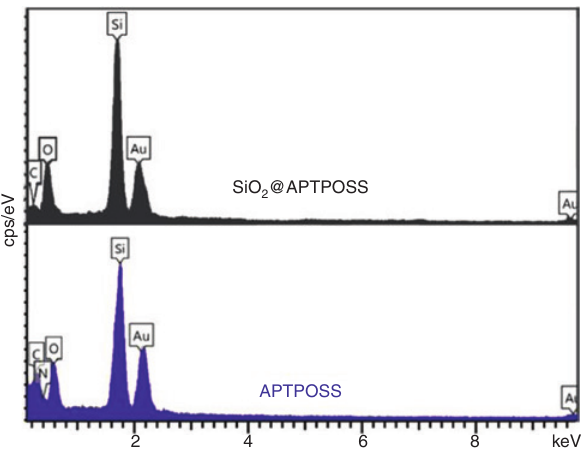
Figure 3: EDS for APTPOSS and nano-colloidal silica @APTPOSS.